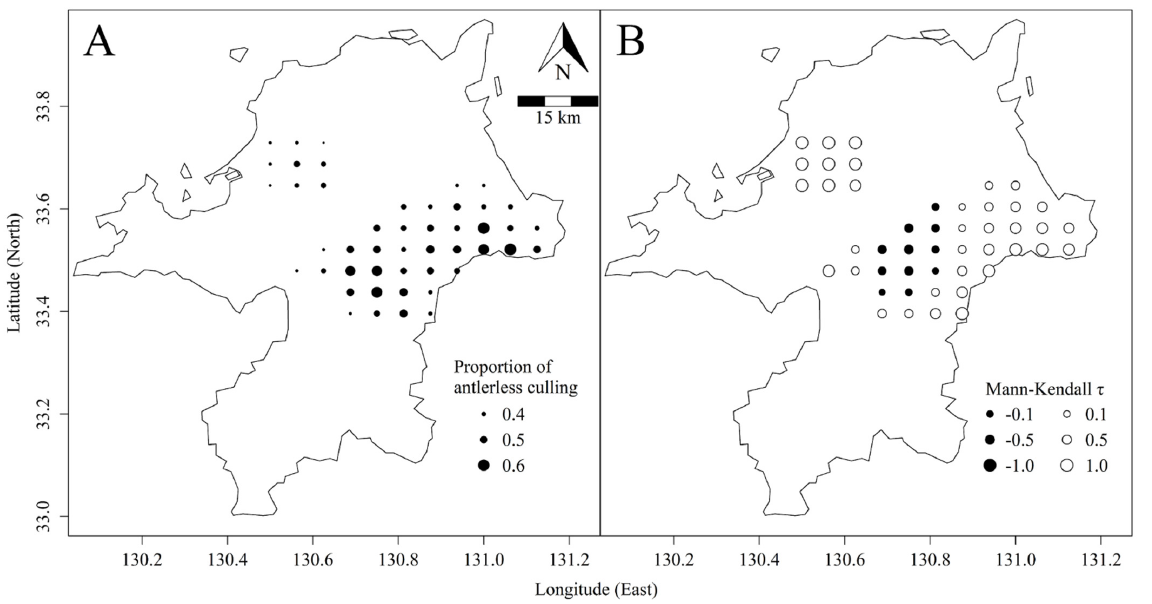
Figure 2. Proportions of antlerless culling of sika deer ( A ) and deer density trends ( B ) in Fukuoka Prefecture, Japan. Table 1. Number of sites and surveys of the faecal pellet count in each prefecture.